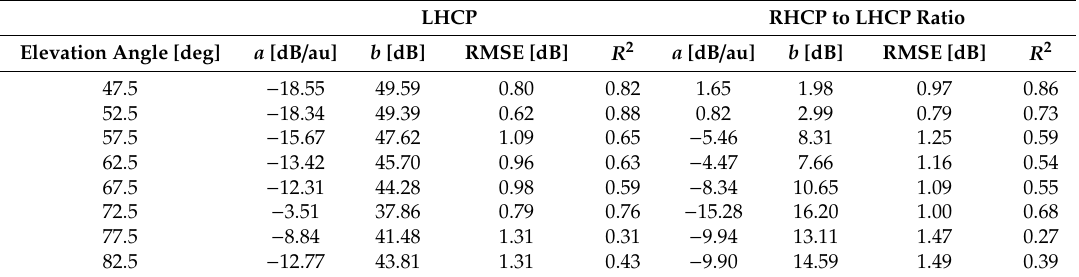
Table 2. RHCP and LHCP C / N 0 , and Co- to Cross-polar Ratio vs. NDVI Fitting Parameters.